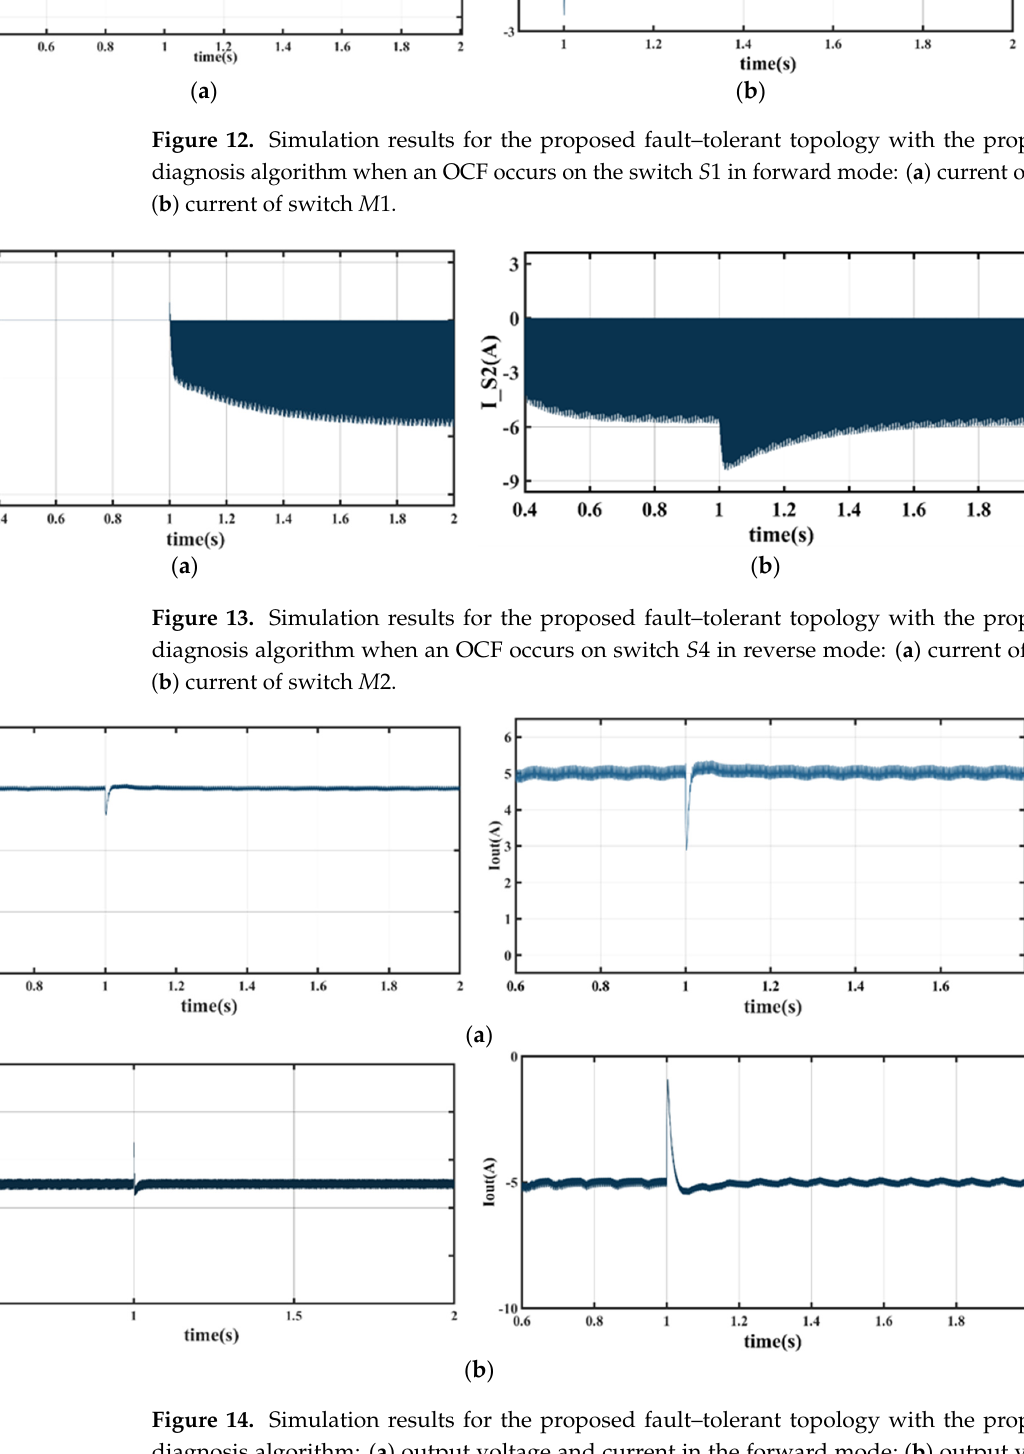
agnosis algorithm: ( a ) output voltage and current in the forward mode; ( b ) output voltage and cur- rent in the reverse mode.